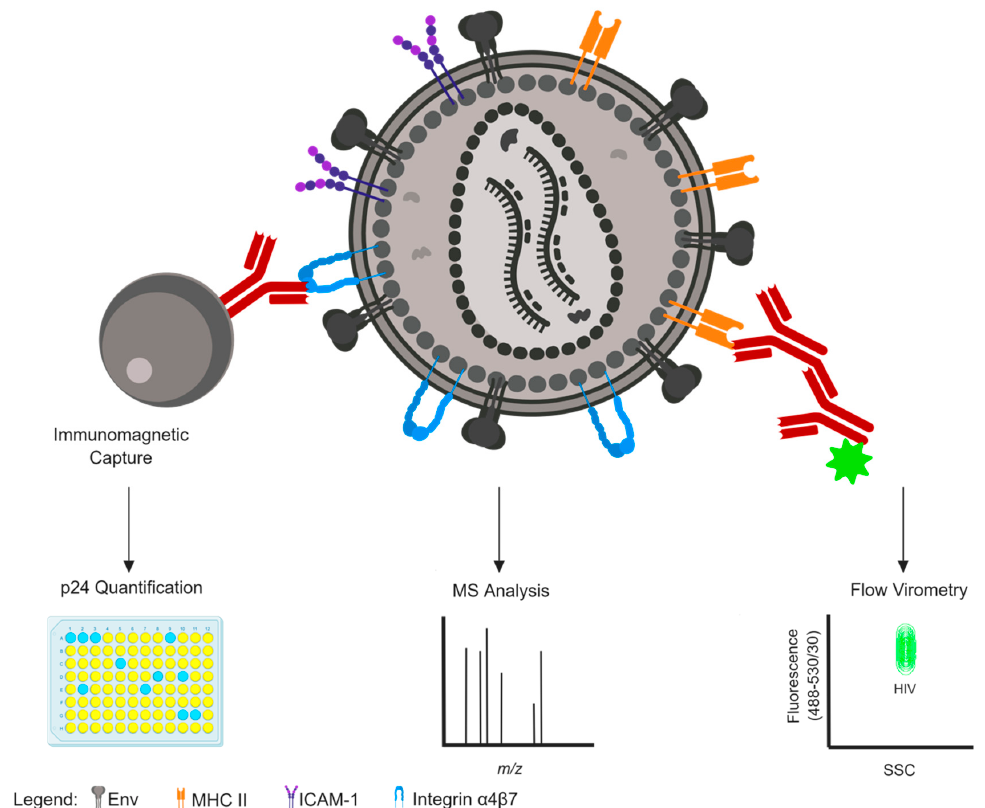
Figure 1. Methods to detect host protein incorporation on the surface of an HIV-1 virion. An HIV-1 particle is depicted with surface antigens displayed, including the viral envelope glycoprotein (Env, grey) and host cell proteins MHC II (orange), CD54/ICAM-1 (purple), and integrin α 4 β 7 (blue). Immunomagnetic bead capture (left) is one common and crude method to determine surface antigen expression on virion surfaces, quantified by p24 antigen ELISA readout. Mass spectrometry (centre) is another common and crude method to detect host protein incorporation that might offer enhanced sensitivity over immunocapture, but cannot distinguish the location of incorporated proteins from virion surface versus virion interior. Flow virometry (right) is an emerging technology for the flow cytometry-based detection of nanoparticles, permitting highly sensitive detection of unique virion populations that can be distinguished based on scattering properties ( x -axis) and fluorescence expression ( y -axis) within virions or via staining with fluorochrome-conjugated antibodies (maroon). This figure was created with BioRender.